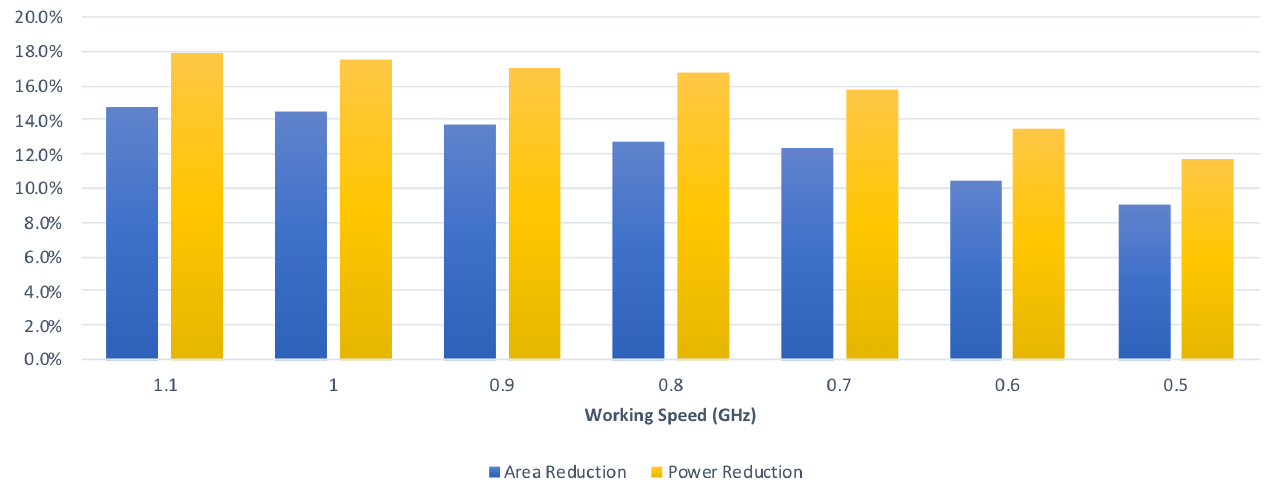
Figure 20. The reduction rates of the proposed CA-W design under different timing